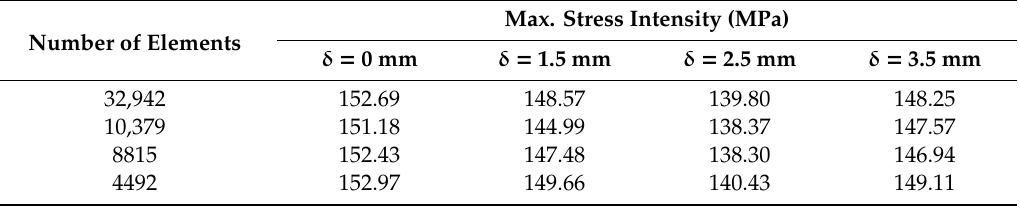
Table 5. Maximum stress intensity on the di ff erent maximum mesh element sizes at the di ff erent o ff set arrangements ( δ ).